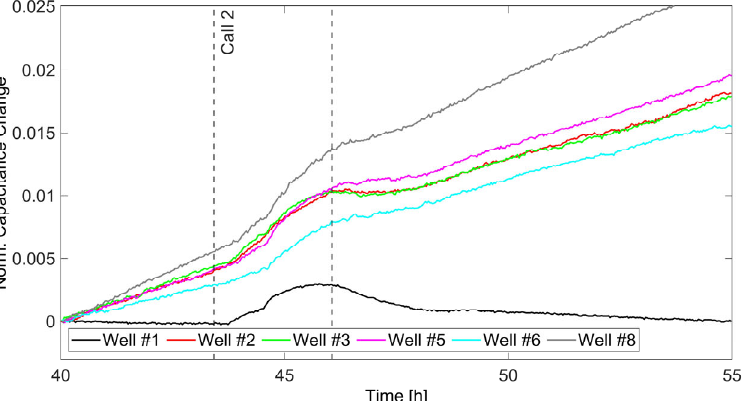
Figure 13. Measurement results of resistance for f = 62.5 Hz in normalized values for 6 wells (without #4 and #7). Well #1 (not containing cells) is shown in black. The dashed line marks the start and end of the phone call.